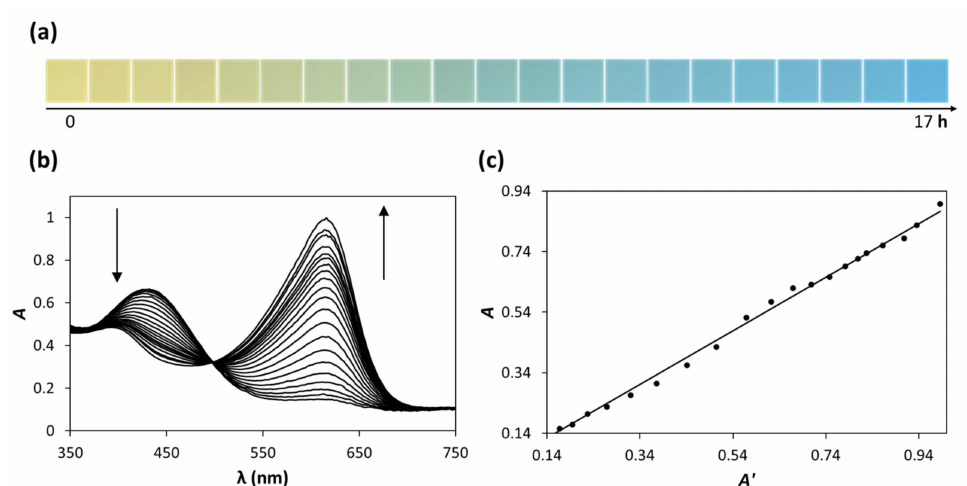
Figure 1. Regularly recorded, ( a ) digital photographic images and ( b ) UV-vis absorption spectra of a NaHCO 3 aqueous solution (1.43 mM) containing 2.71 × 10 − 5 M BTB, initially saturated with 100% CO 2 for 10 min and then allowed to lose the dissolved CO 2 to ambient air over time and ( c ) subsequent plot of A vs. A (cid:48) for the same solution, with values of A and A (cid:48) determined from the UV-vis spectra in ( b ) and the photographic images in ( a ),